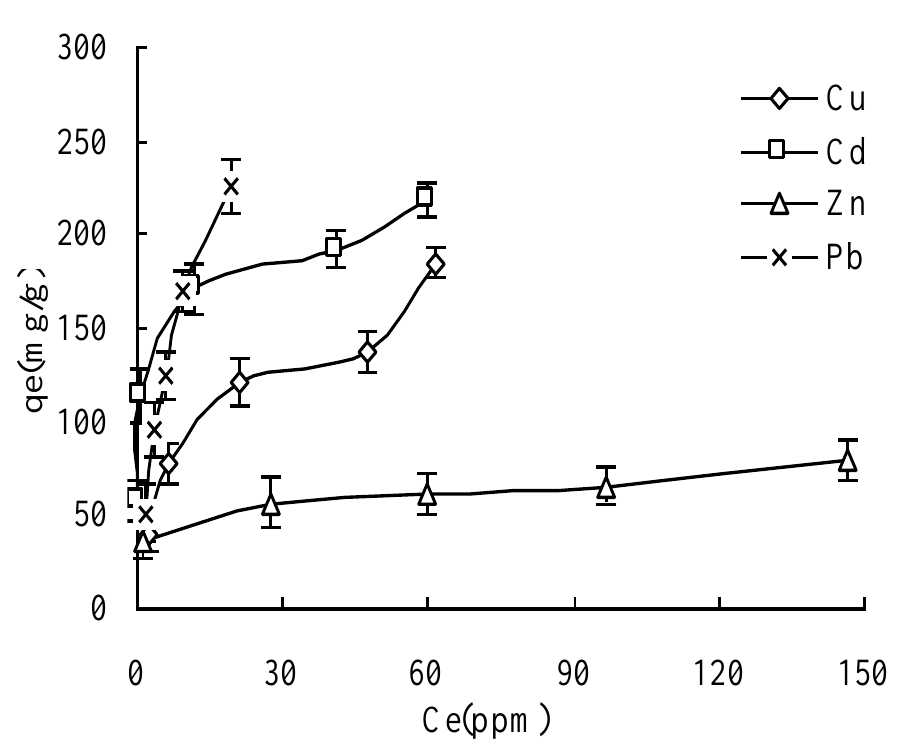
Figure 7. Adsorption isotherms of metal ions on crayfish carapace (agitation speed = 180 rpm; equilibrium time = 2 h; temperature = 25 °C; initial pH = 5.5; dosage = 1.0